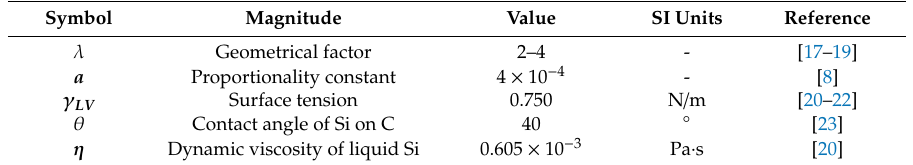
Table 3. Parameters used for the calculation of the infiltration time of liquid Si on the different preforms at 1450 °C.